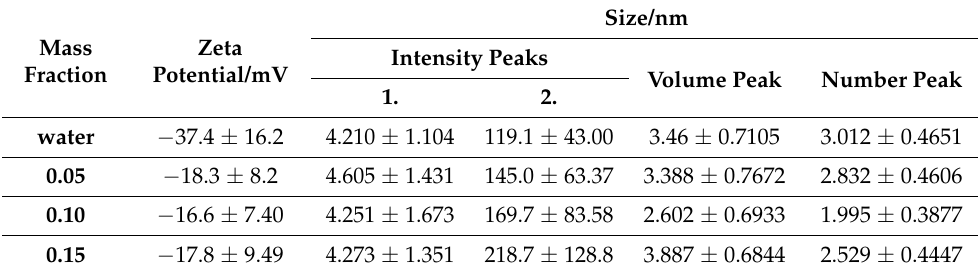
Table 3. Size distribution and zeta potential of SDS in the binary mixture of water–propane-1,2-diol at the same surfactant concentration (0.01 mol dm − 3 SDS solution).